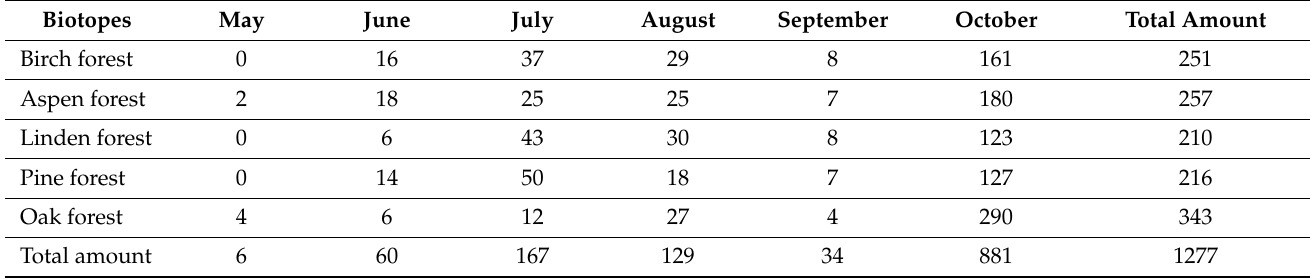
Table A1. Seasonal dynamics of Drosophila obscura in five